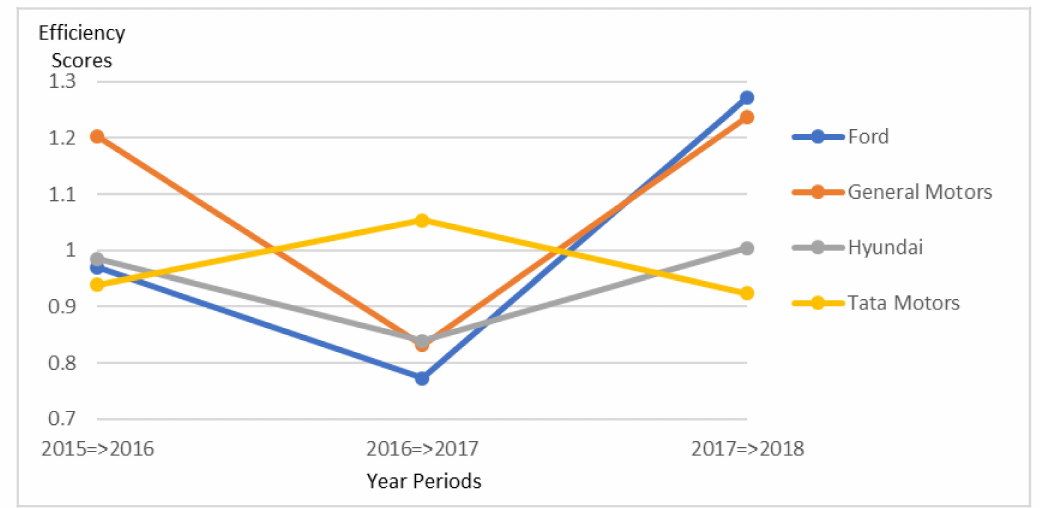
Figure 7. Technical-e ffi ciency changes of US, Korean, and Indian automakers.